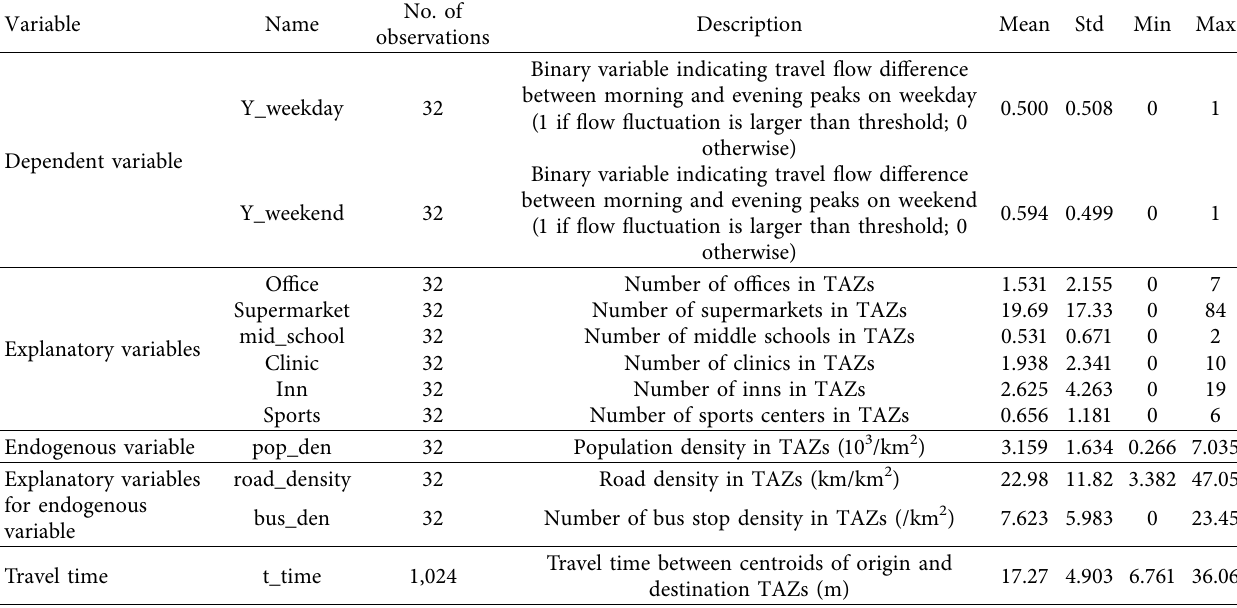
Table 2: Descriptive statistics of